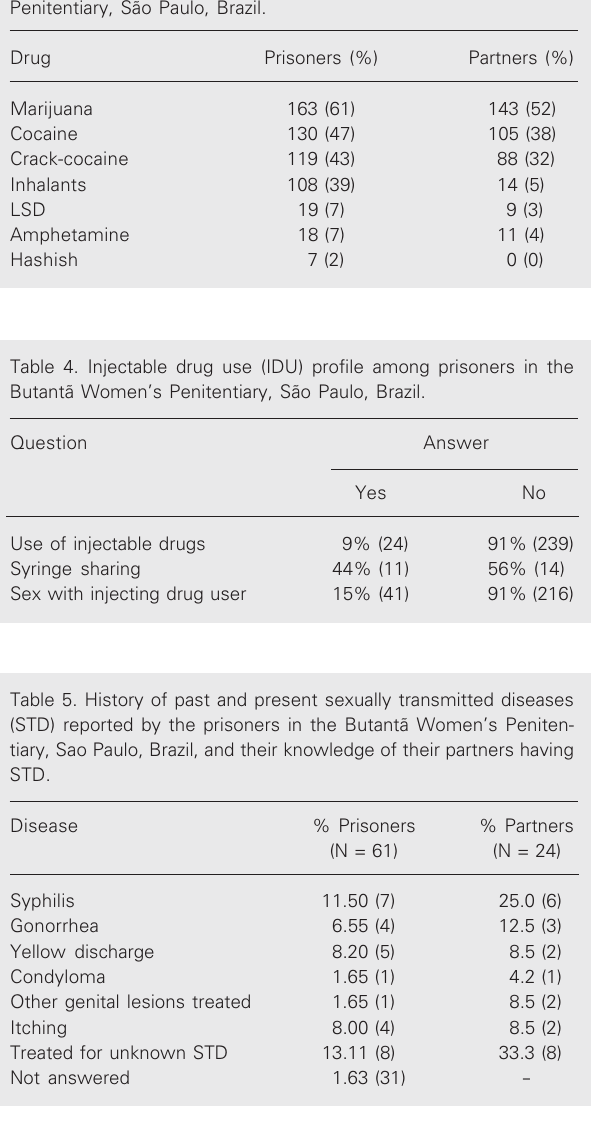
3. Drug use profile among female prisoners and their